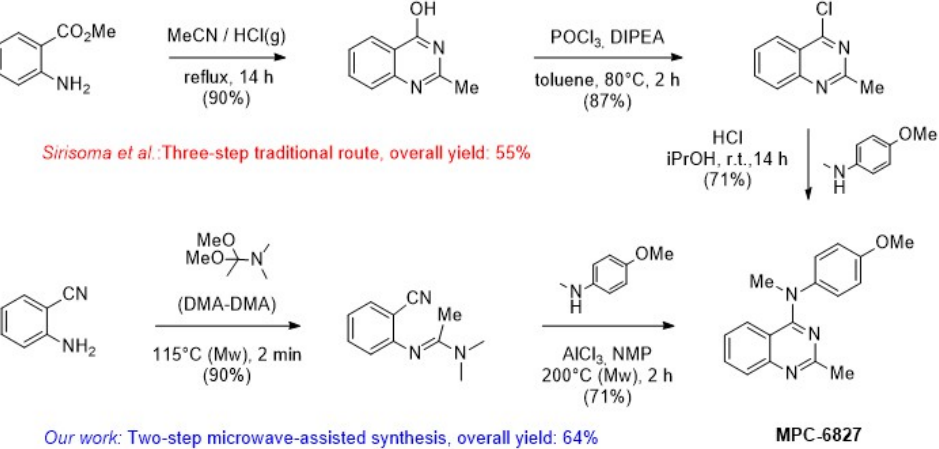
Figure 1. Synthetic routes of MPC-6827 described by Sirisoma et al . and our group a decade ago.